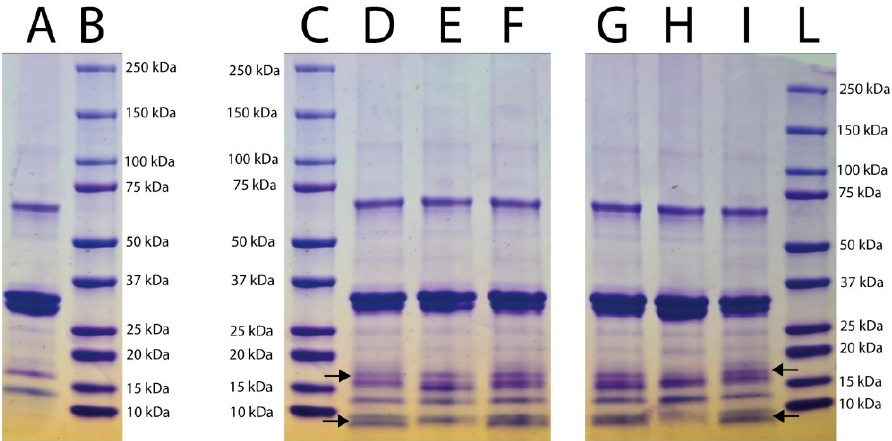
Figure 3. SDS-PAGE patterns of semi-skimmed milk treated with aqueous extract of kiwifruit tis- sues. Lane A: control semi-skimmed milk; lanes B, C, L: molecular marker; lane D: ripe fruit pulp; lane E: ripe fruit peel; lane F: ripe whole fruit; lane G: unripe fruit pulp; Lane H: unripe fruit peel; lane I: whole unripe fruit. Arrows indicate the peptides formed after milk hydrolysis.